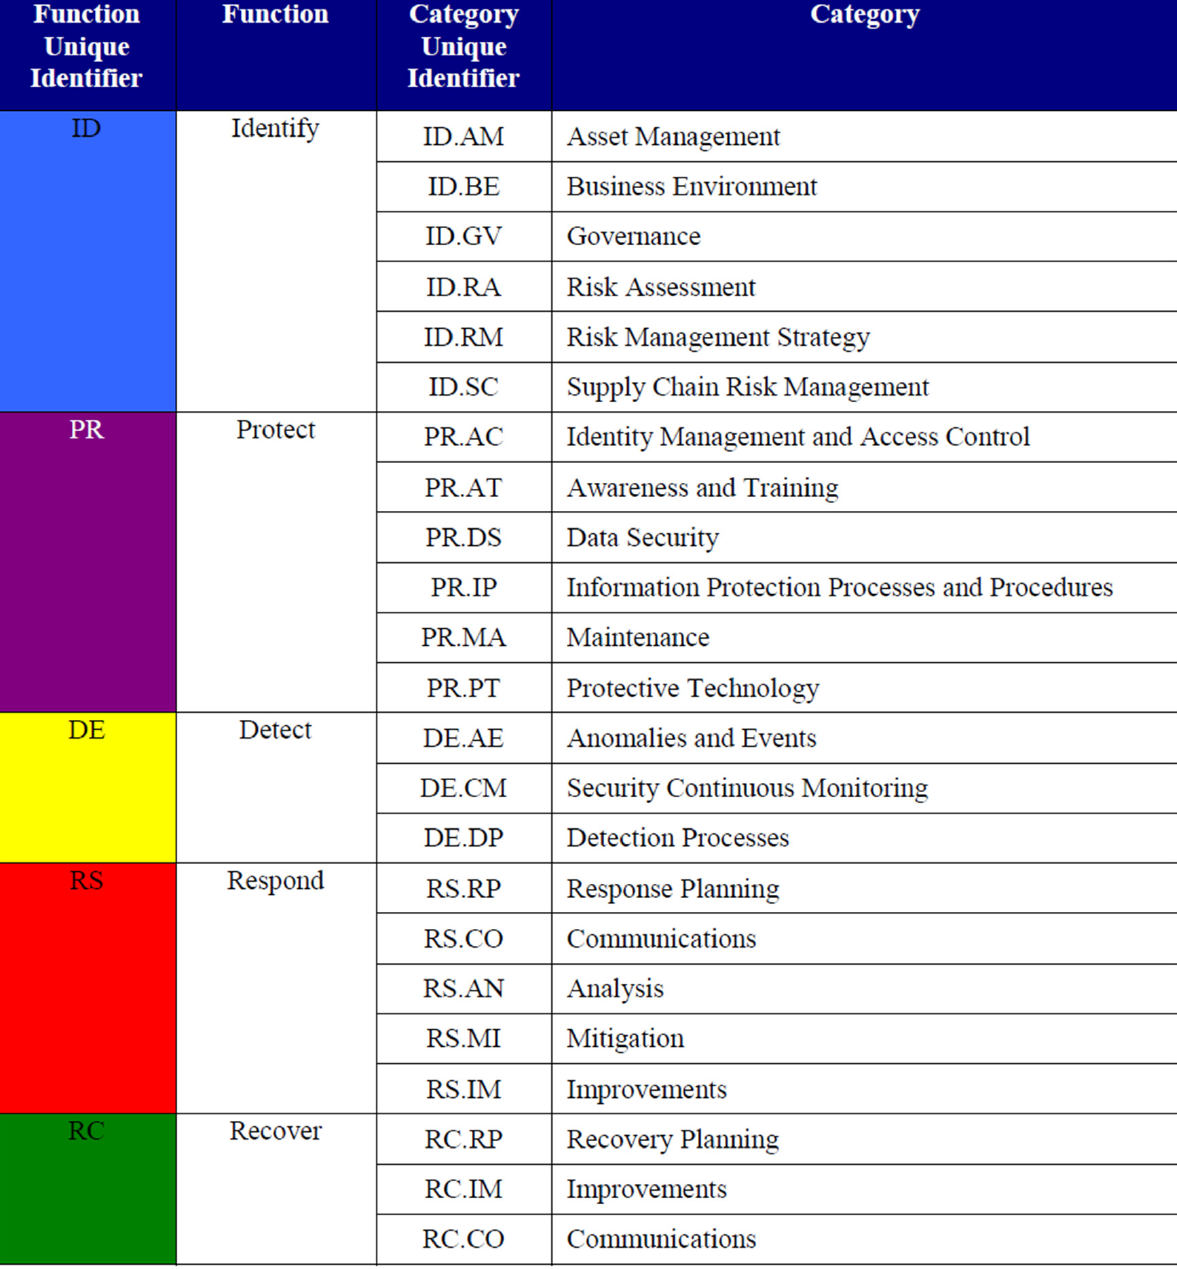
Figure 3. NIST Framework for Improving Critical Infrastructure Cybersecurity: core concepts [24].